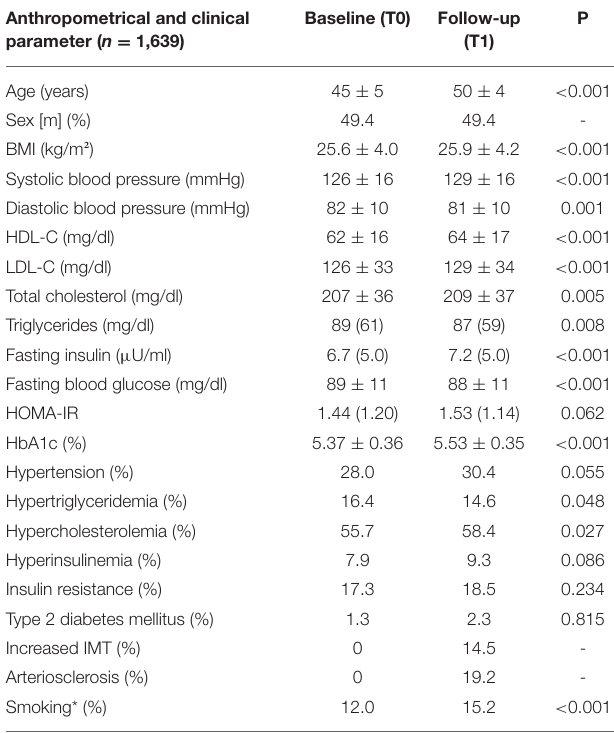
TABLE 1 | Characteristics of study population at baseline and at the first follow-up. Anthropometrical and clinical parameter ( n =